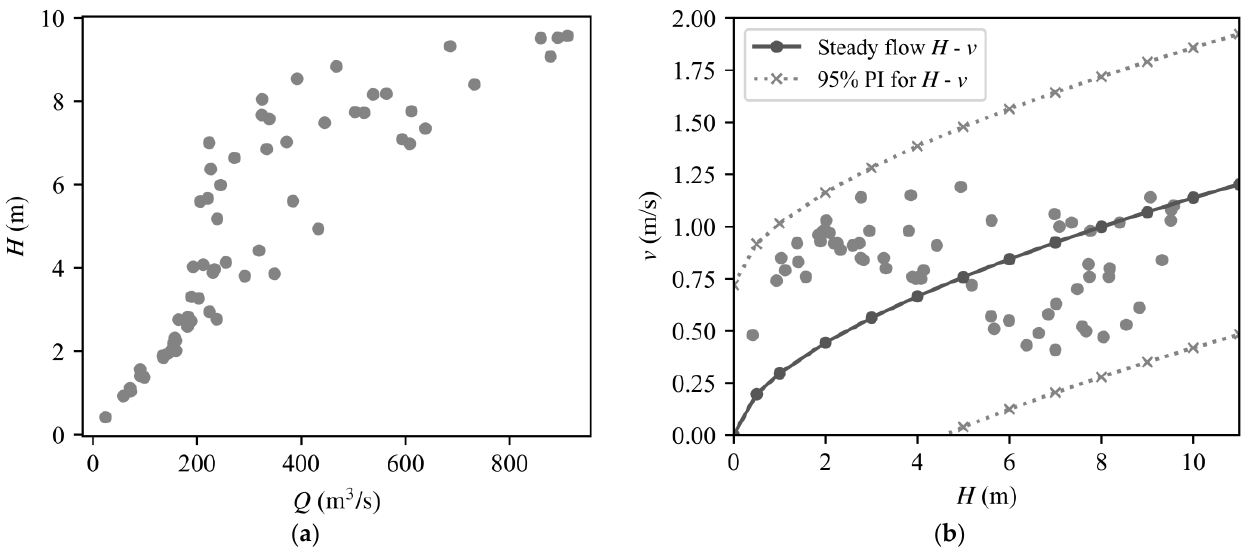
Figure 3. Results obtained from the numerical simulations of two flooding events. ( a ) Relation between water height ( H ) and discharge ( Q ); ( b ) relation between water velocity ( v ) and water height ( H ). The steady flow relationship and the 95% prediction interval curves are also